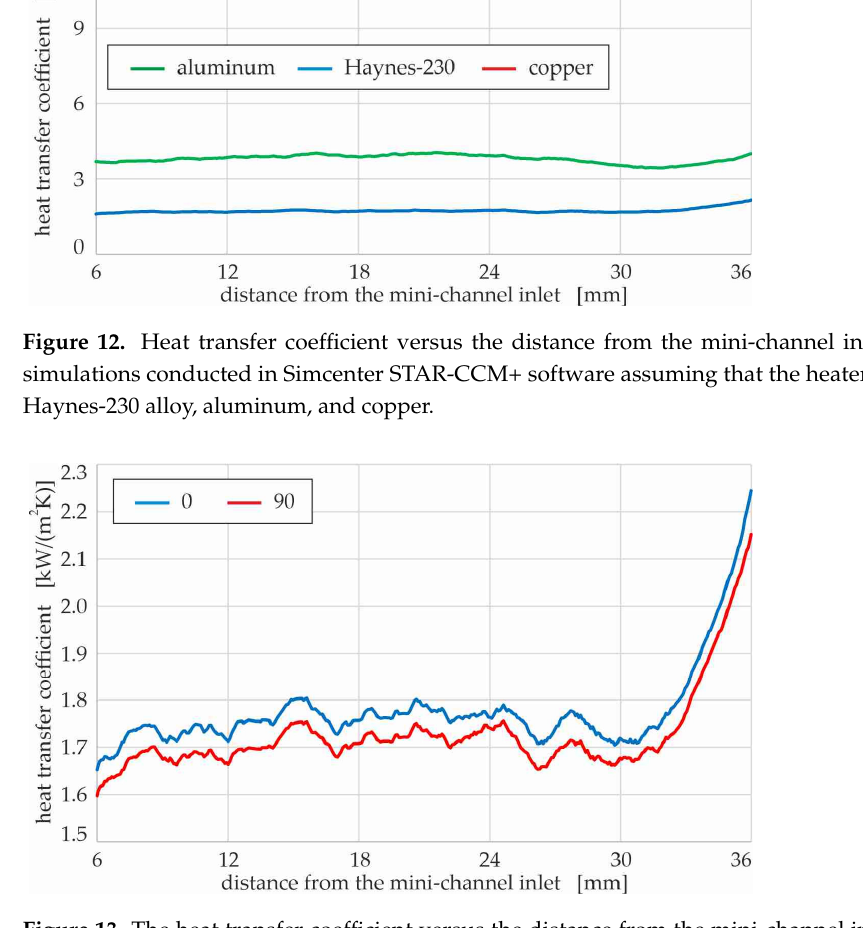
Figure 12. Heat transfer coefficient versus the distance from the mini ‐ channel inlet, numerical sim ‐